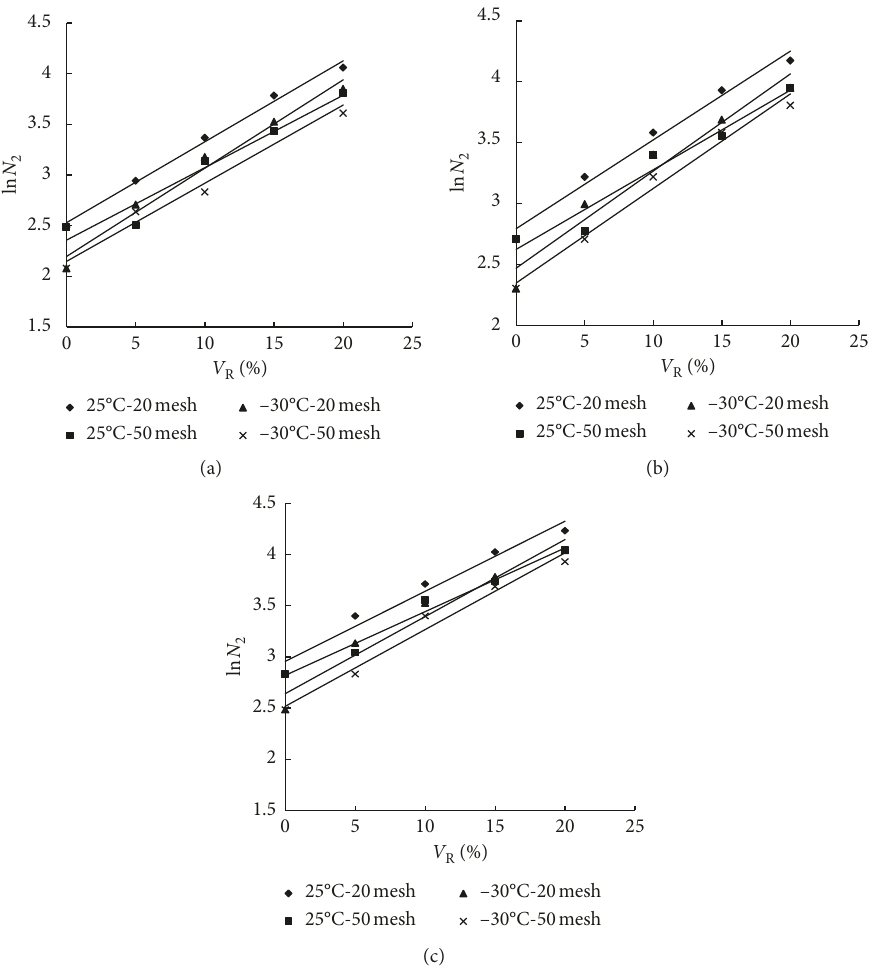
Figure 8: Relationship between ln N